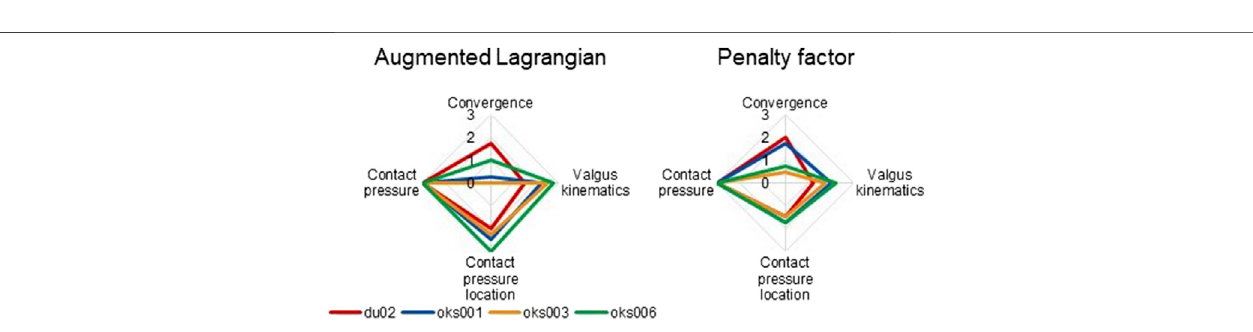
FIGURE 10 | Tibiofemoral cartilage contact parameters sensitivity analysis simulation results rated on in fl uence on convergence, valgus kinematics, peak contact pressure, and location of peak contact pressure (0 (No in fl uence) to 3 (Large in fl uence)).